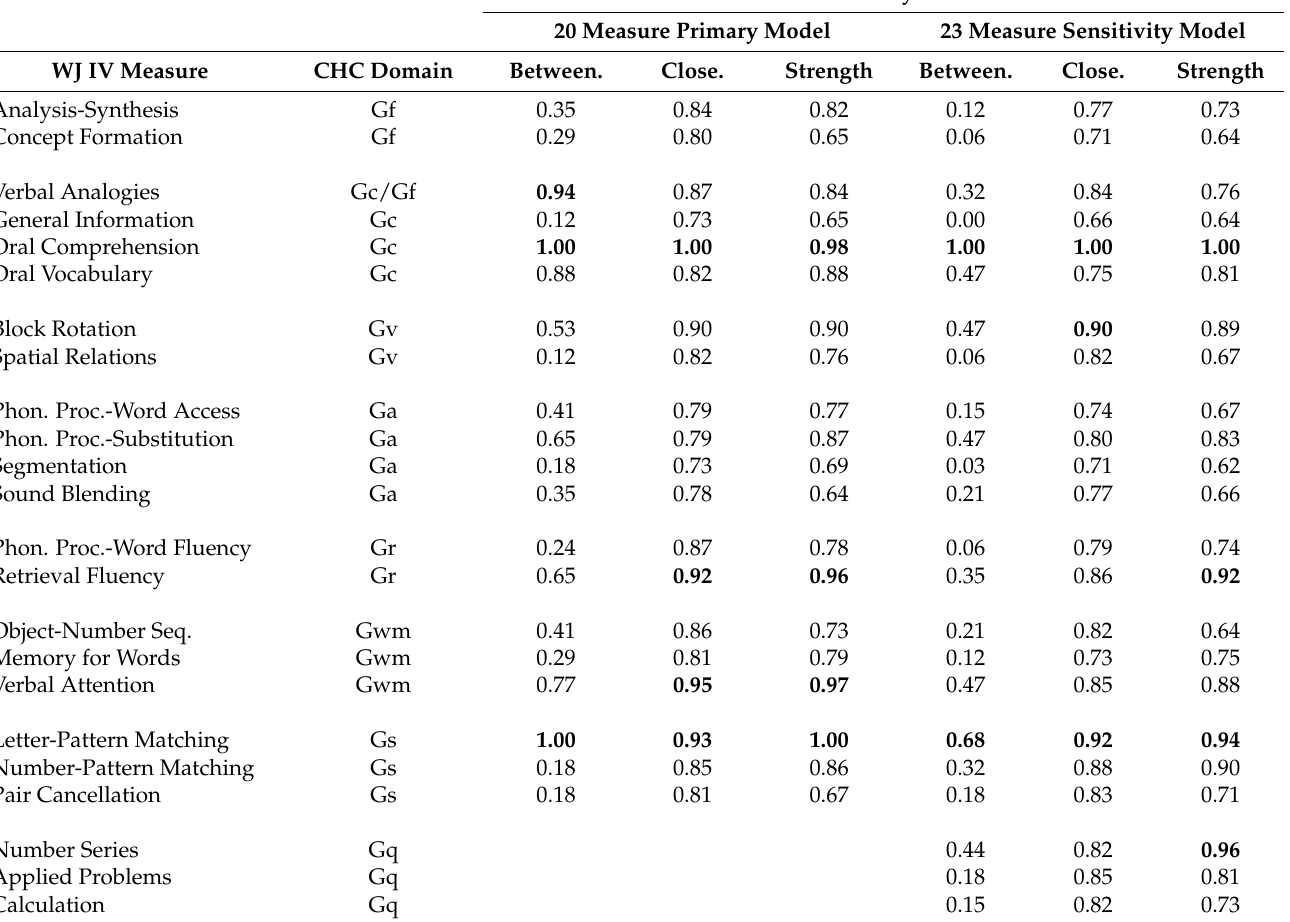
Table 2. 20-measure primary and 23-measure secondary sensitivity network centrality measure